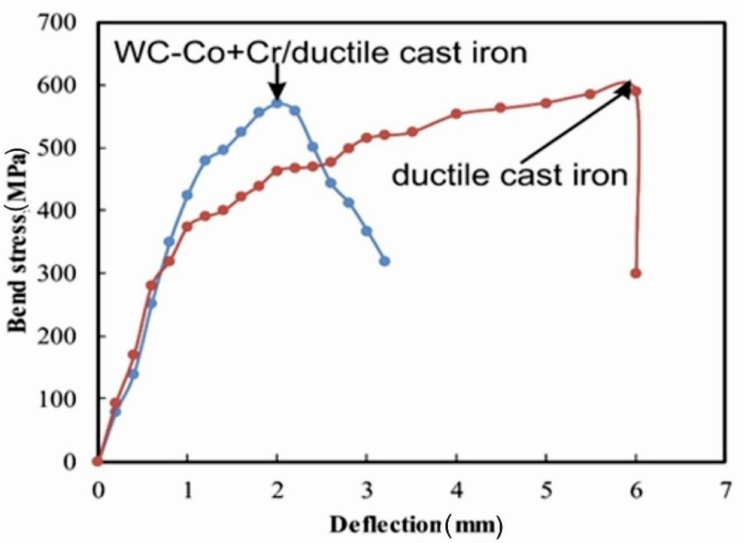
Figure 8. Bend test curves recorded for the ductile cast iron and system type: WC–Co + Cr/ductile cast